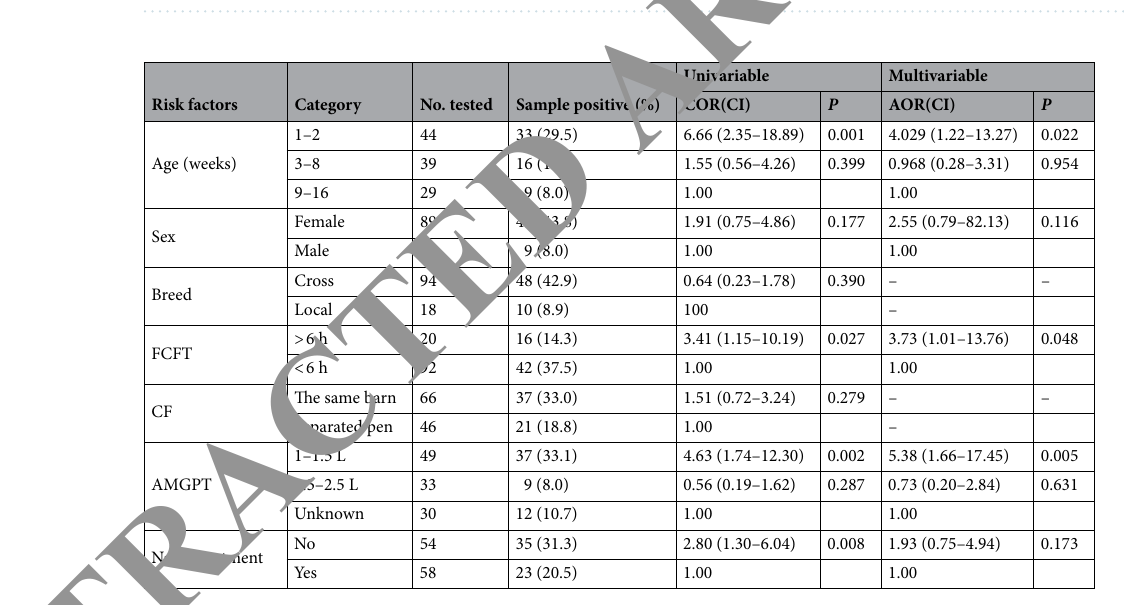
Table 1. Over all occurrence of E. coli isolates with different factors in diarrheic calves. FCFT first colostrum feeding time, AMGPT amount of milk given per time, CF calving facility; χ 2 Chi square, P probability.